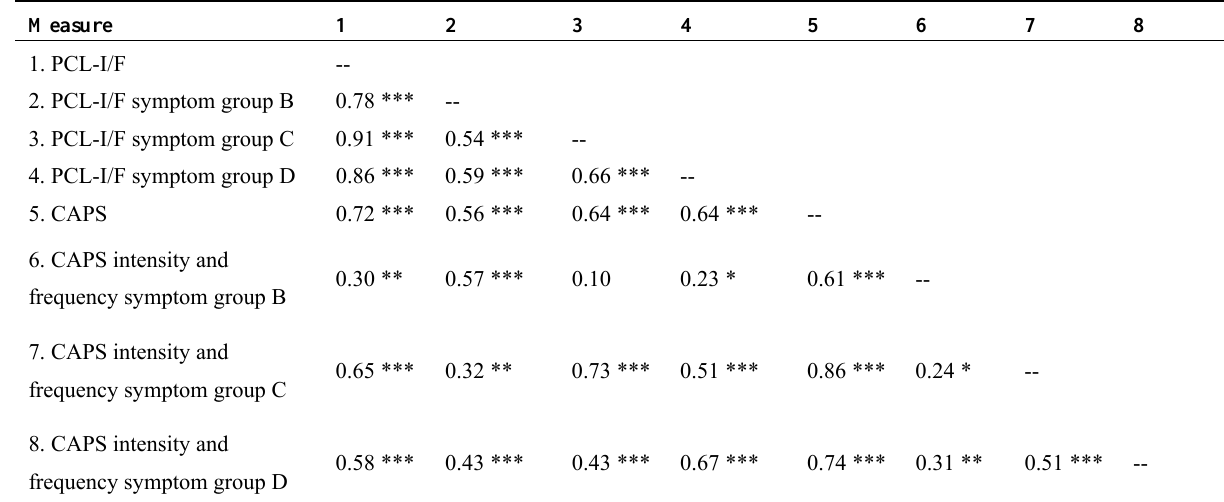
Table 4. Correlation matrix of PCL-I/F and CAPS frequency